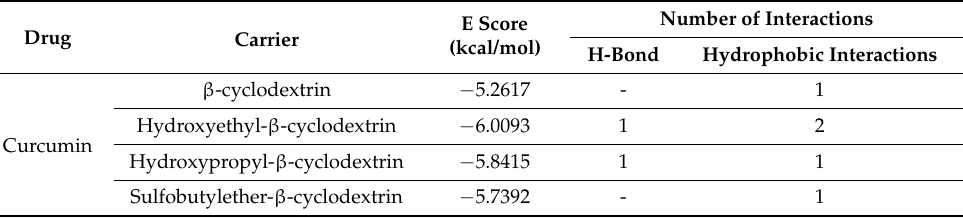
Figure 1. 3D poses for curcumin docked into the inclusion pocket of ( A ) β -cyclodextrin, ( B ) hydroxyethyl- β -cyclodextrin, ( C ) hydroxypropyl- β -cyclodextrin and ( D ) sulfobutylether- β -cyclodextrin showing (i) top view, (ii) bottom view (iii) side view (iv) top view with marked interactions demonstrating bond length. Table 1. Energy score (kcal/mol) and number of potential interactions observed for Curcumin docked into the inclusion pocket of β -cyclodextrin, Hydroxyethyl- β -cyclodextrin, Hydroxypropyl- β -cyclodextrin, and sulfobutylether- β -cyclodextrin.